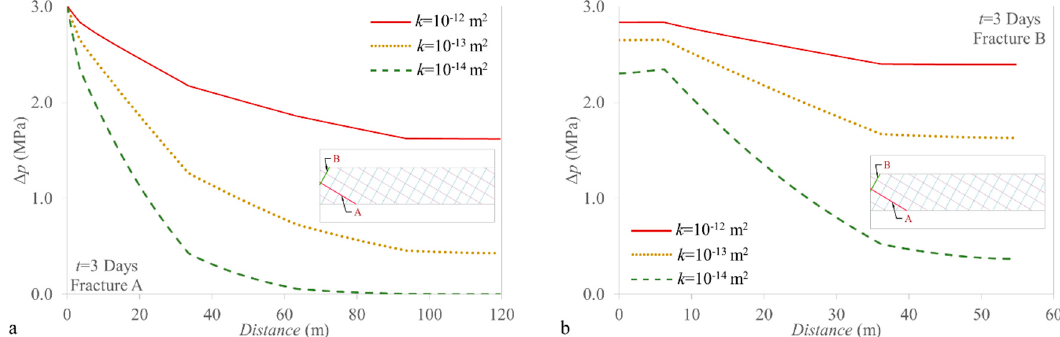
Figure 2. Fluid pressure changes along the fractures with different dips as a function of the distance, ( a ) fracture A (dip − 30°) and ( b ) fracture B (dip 60°). Note that the changes in the pressure gradient coincide with intersections with other fractures.